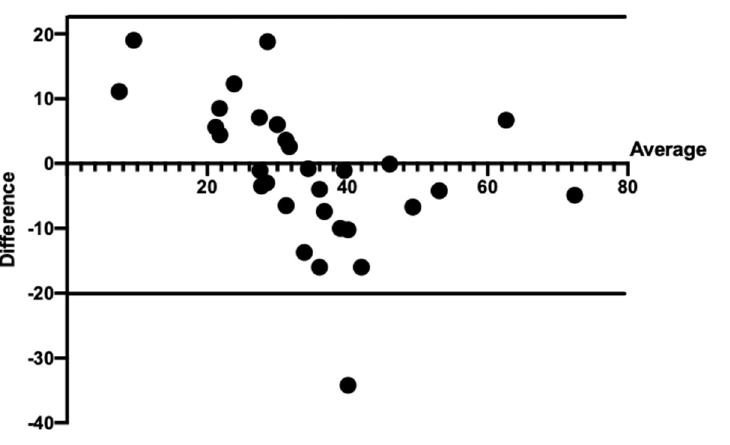
Figure 4. Bland–Altman scatterplot. The red line represents the mean of the differences between the methods. The space between the upper and lower green lines represents the limits of agreement.